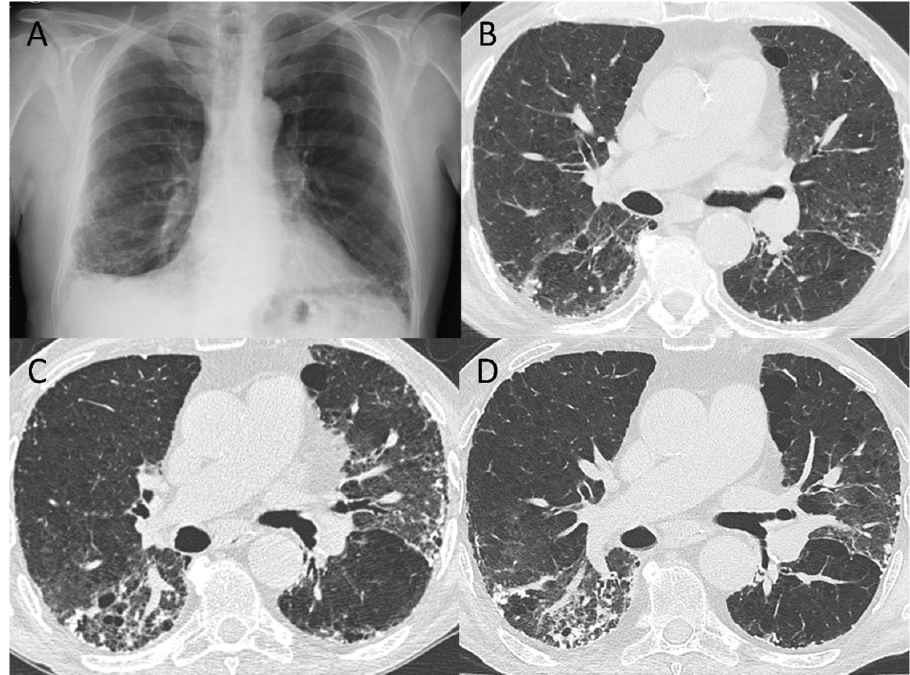
Figure 3. Representative images of a patient who had initial signs of interstitial lung disease at the lower lung zones in a chest X-ray ( A ) performed 2 years earlier than the baseline CT scan at COVID-19 diagnosis ( B ). In the 3-month ( C ) and 6-month ( D ) follow-up CTs the pattern was classified as residual fibrotic changes, possibly in keeping with COVID-19-induced progression of a pre-existing interstitial lung disease.